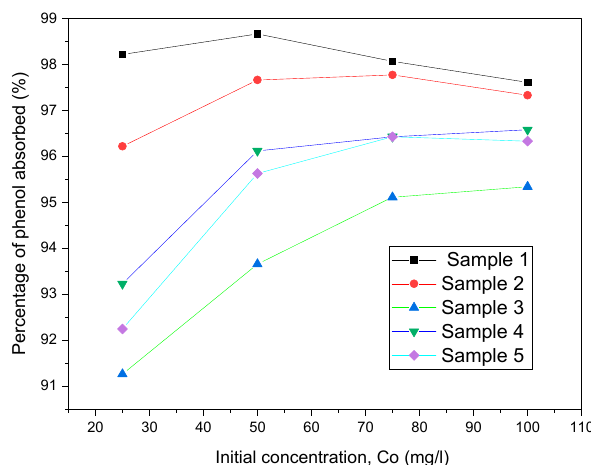
Figure 4. The effect of initial concentration on percentage of phenol adsorbed (50 mL of phenol solution and 0.1 magnetic nanopowder).